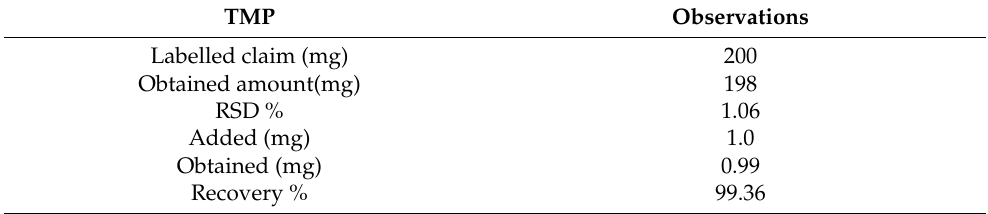
Table 2. Tablet analysis of TMP.